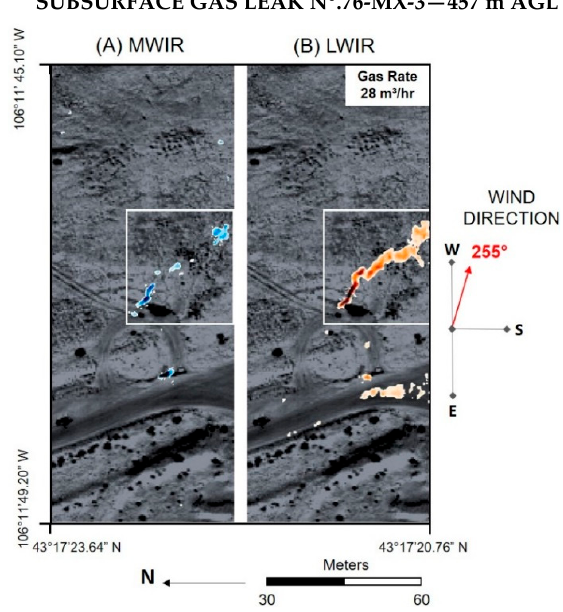
Figure 5. Detection of CH 4 plumes in the ( A ) MWIR and ( B ) LWIR ranges—SEBASS flight performed on 20th August 2010 over station 76-MX-3 (gas source: RMOTC) at 11:39:17 (local time) with 0.50 m spatial resolution and at 457 m above ground level (AGL). The red square indicates the ground station location (i.e., source of gas leak) and the respective plume. Pixels in blue ( A ) and red ( B ) indicate the occurrence of methane in the scenes. The main direction of the wind is displayed in the diagram on the right side of the figure (data collected between 11:30 p.m.–12:30 p.m.).